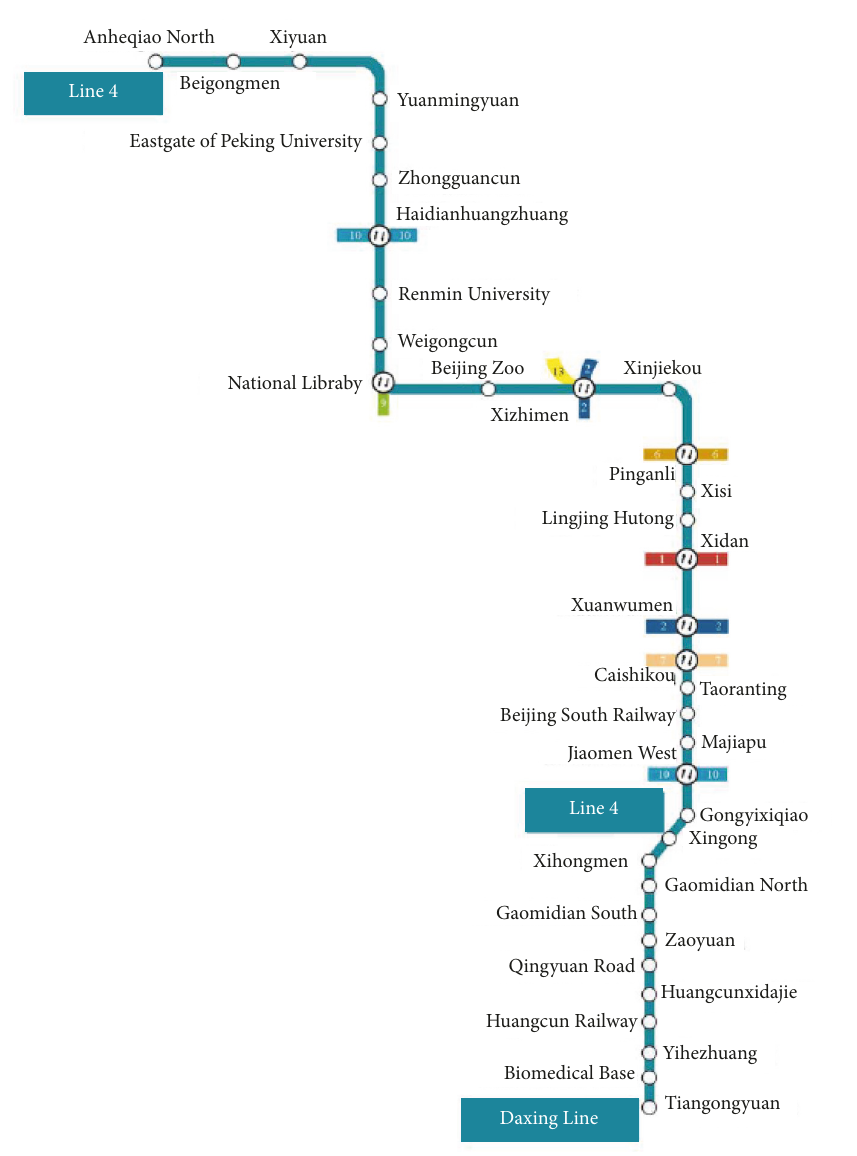
Figure 9: The layout of the Beijing Subway line